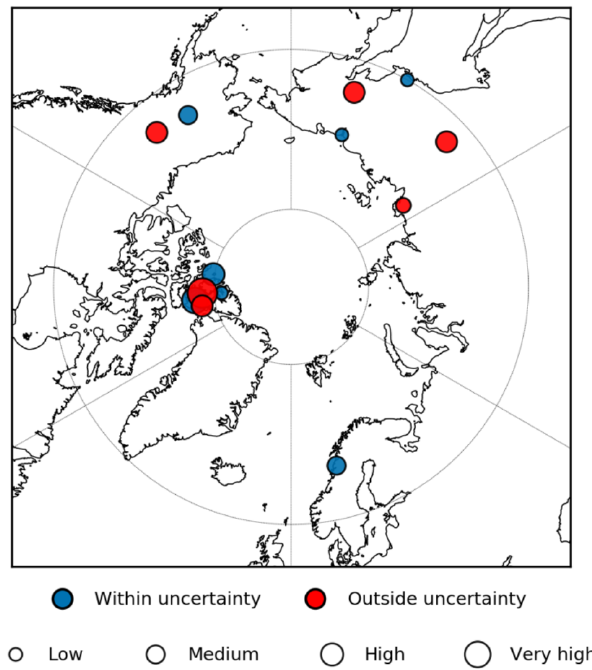
Figure 9. Blue circles highlight where at least one model in the ensemble simulates a temperature that falls within the uncertainty range of the reconstruction. The size of SAT reconstructions is scaled by qualitatively assessed confidence levels (Salzmann et al., 2013). Data markers for reconstructions in close proximity of each other have been slightly shifted for improved